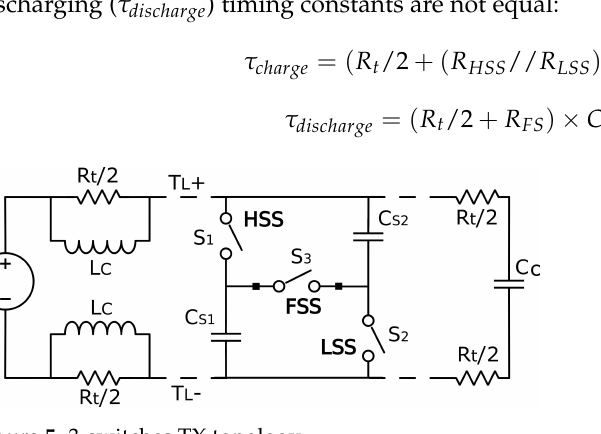
Figure 5. 3-switches TX